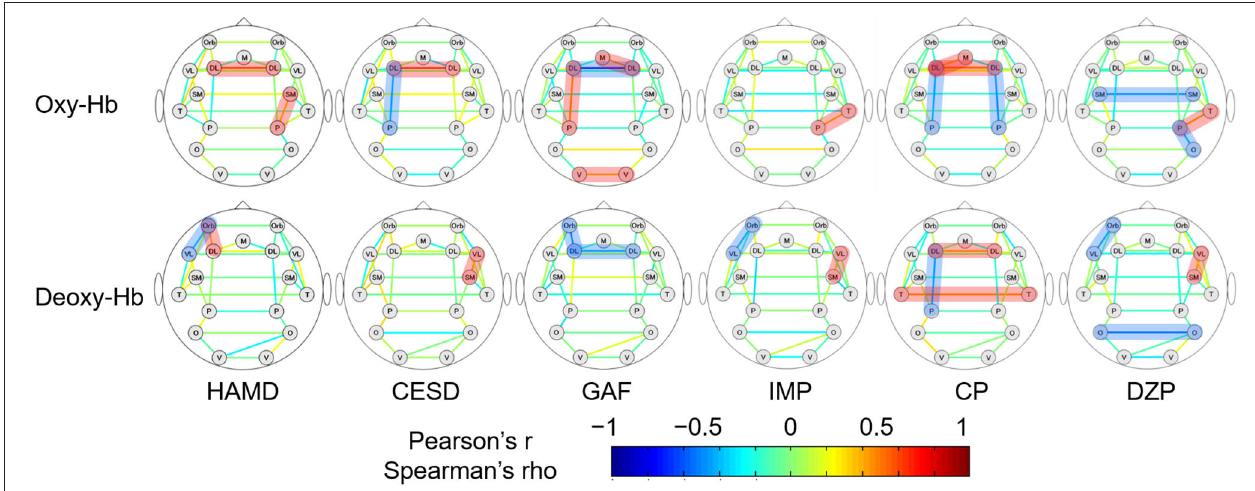
FIGURE 3 | The association between the strengths of RSFCs and clinical variables in MDD patients. The upper and lower rows show the RSFC patterns calculated from oxy- and deoxy-Hb signals, respectively. Pearson’s correlation coefficients are depicted for CESD and GAF, while Spearman’s rank correlation coefficients are depicted for the rest. The brain region pairs, where the correlation between the strengths of RSFCs and the clinical variables were significantly different between the groups are highlighted in red (positive correlation) or blue (negative correlation). HAMD, 17-item Hamilton rating scale for depression; CESD, Center for Epidemiologic Studies depression scale; GAF, global assessment of functioning; IMP, imipramine equivalent of antidepressant dosage; CP, chlorpromazine equivalent for antipsychotic dosage; DZP, diazepam equivalent for anxiolytic dosage; DL, dorsolateral prefrontal cortex; M, medial prefrontal cortex; Orb, orbitofrontal cortex; VL, ventrolateral prefrontal cortex; SM, sensorimotor area; P, parietal lobe; T, temporal lobe; O, occipital lobe; V, visual